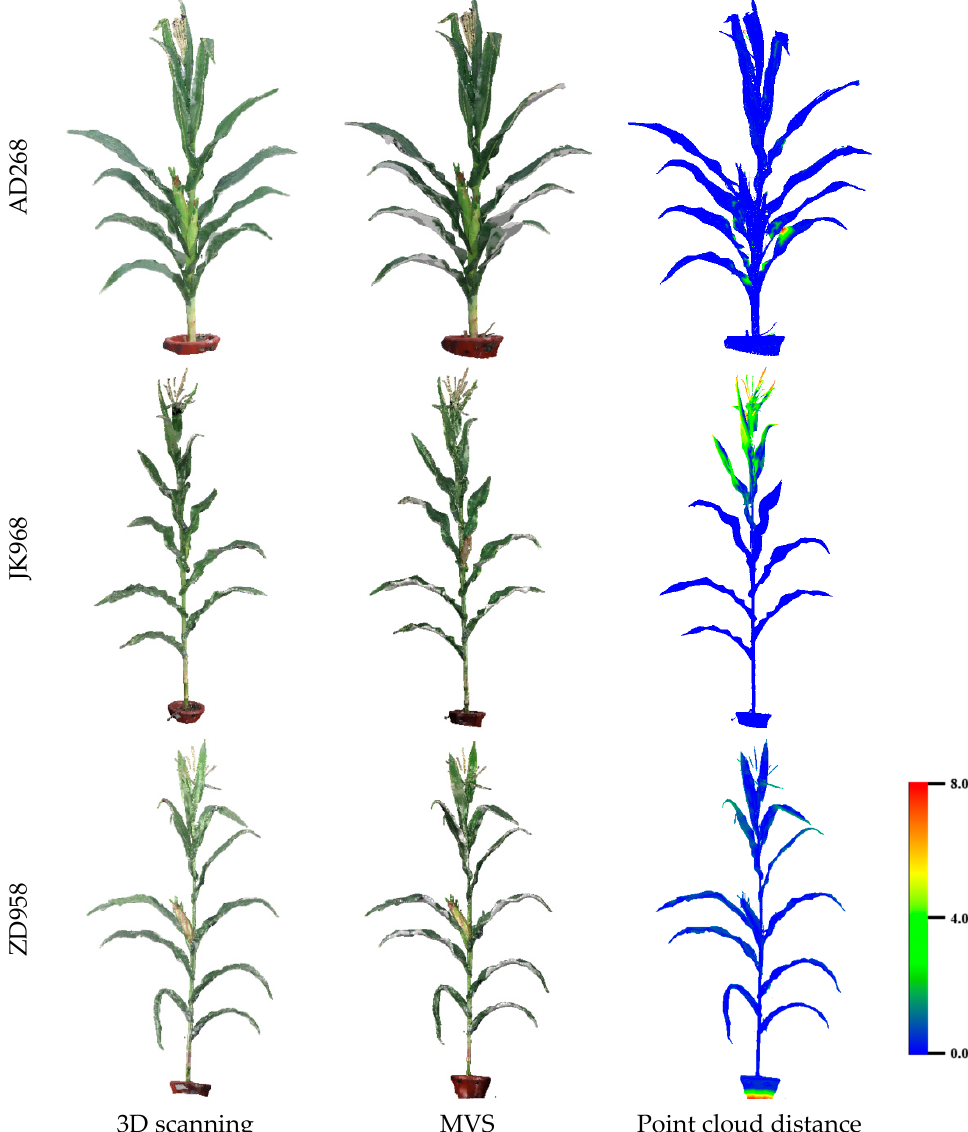
Figure 6. Maize plants point clouds comparison derived using 3D scanning and MVS reconstruction at R1 stage (80th day after sowing).